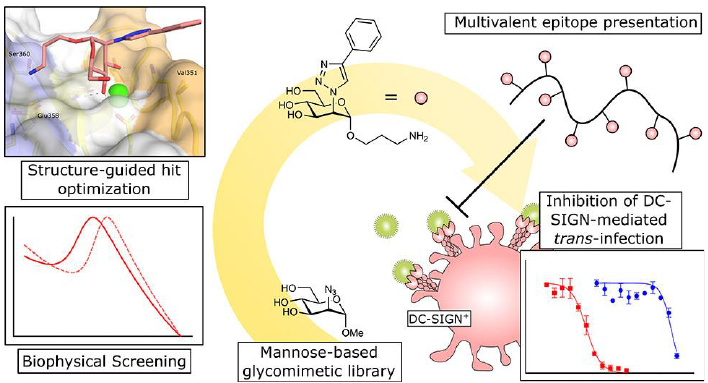
Figure 13. Interaction of triazole − based mannose analogues with DC − SIGN cells. Figure reproduced from ref. [53] with permission.